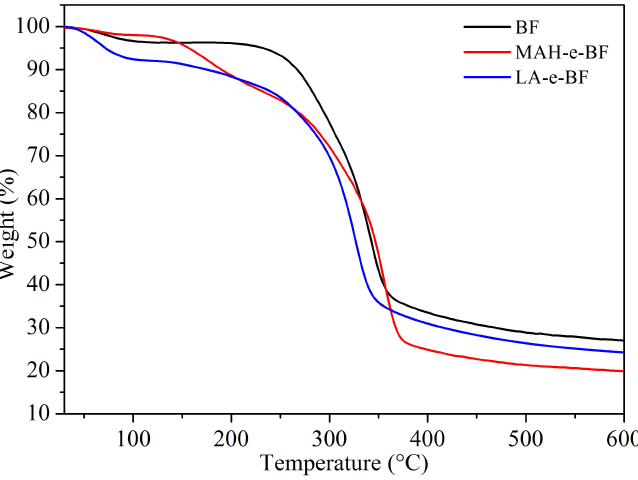
Figure 8. Thermogravimetric analytical (TGA) curves of BF, MAH-e-BF, and